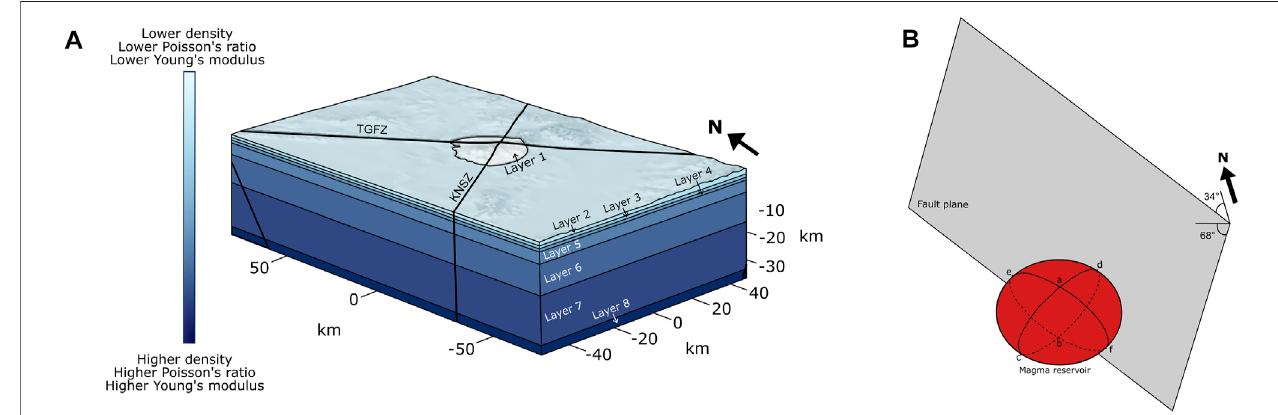
FIGURE 2 | Set up of the 3D fi nite element model. (A) Layered crustal mechanical heterogeneities are represented by subdomains with properties de fi ned in Table 3 . The modelled subsurface architecture shows an increase in mechanical rigidity and density with depth. TGFZ: Tuz Gölü fault zone; KNSZ: Karaman-Ni ğ de shear zone. An oblate cavity [shown in (B) ] centred at [0, 0, − 5000], but not shown for clarity represents the magma reservoir ofHasan Da ğ . (B) Schematic (not toscale) of the modeled relationship between the AKFS ’ s fault plane and Hasan Da ğ ’ s magma reservoir. The magma reservoir is located towards the south-eastern end of the fault